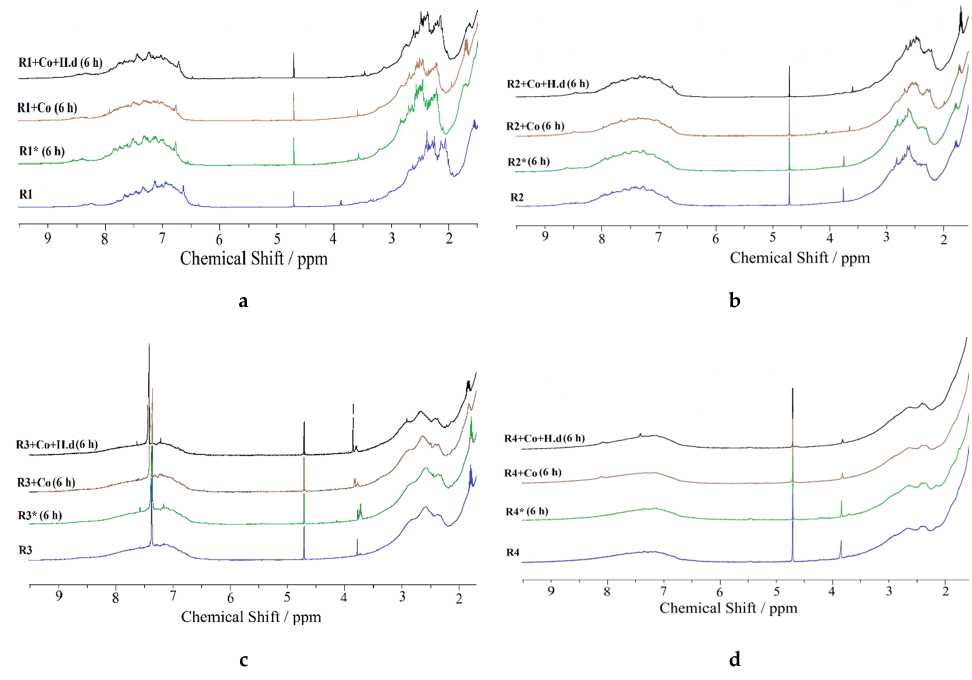
Figure 5. 1 H NMR spectra of resin fractions: ( a ) R1; ( b ) R2; ( c ) R3; ( d ) R4.